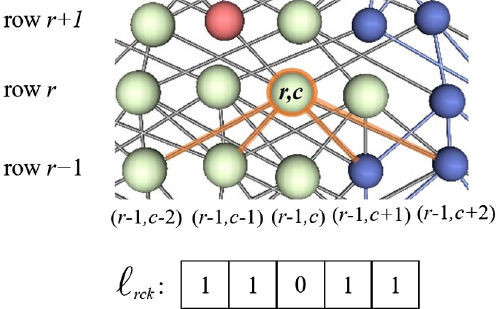
FIG. 12. Illustration of the percolation rules for shearability and fluid or solid states. Note that site ð r; c Þ is turned solid because it is attached to two solid sites below it. Also note that the red site above it is fluid, because it is attached to less than two solid sites below it. But it is not shearable because it does not connect to a shearable site below it. On the other hand, the top right-hand site is shearable and fluid, since it is attached to only one solid site [namely, ð r; c Þ ] and no others on the invisible part of the structure (as seen by its blue connections), and it is also connected to the blue site at ð r; c þ 2 Þ